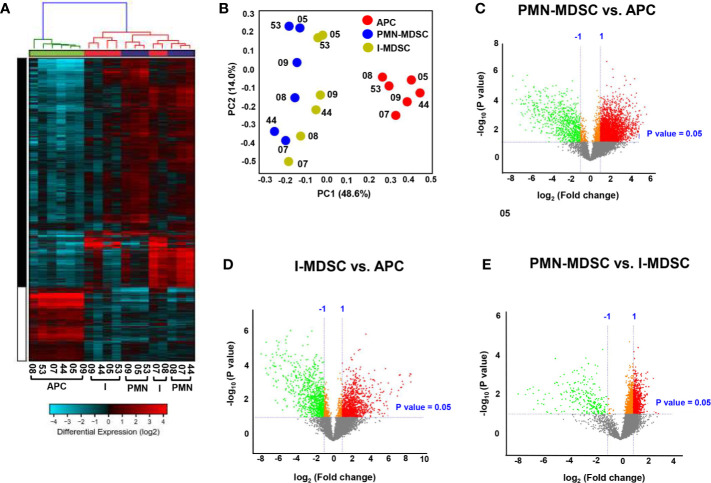
Hierarchical clustering and comparison of myeloid cell subpopulations (PMN-MDSCs, I-MDSCs and APCs) in tumor tissue of CRC patients. Cells isolated from tumor tissues of six CRC patients were stained for myeloid cell markers and sorted for RNA extraction. Hierarchical clustering of APCs, I-MDSCs and PMN-MDSCs from six tumor tissues (CRC patients #05, 07, 08, 09, 44 and 53) based on differentially-expressed RNA transcripts. Each column represents a sample and each row represents a transcript. Expression level of each gene in a single sample is depicted according to color scale (A). Principle component analysis (PCA) based on the differentially expressed genes in each myeloid subpopulation (B). Volcano plots show genes that were upregulated (shown in red), downregulated (shown in green) or remained unchanged (shown in grey) when comparing PMN-MDSC vs. APC (C), I-MDSC vs. APC (D) and PMN-MDSC vs. I-MDSC (E).